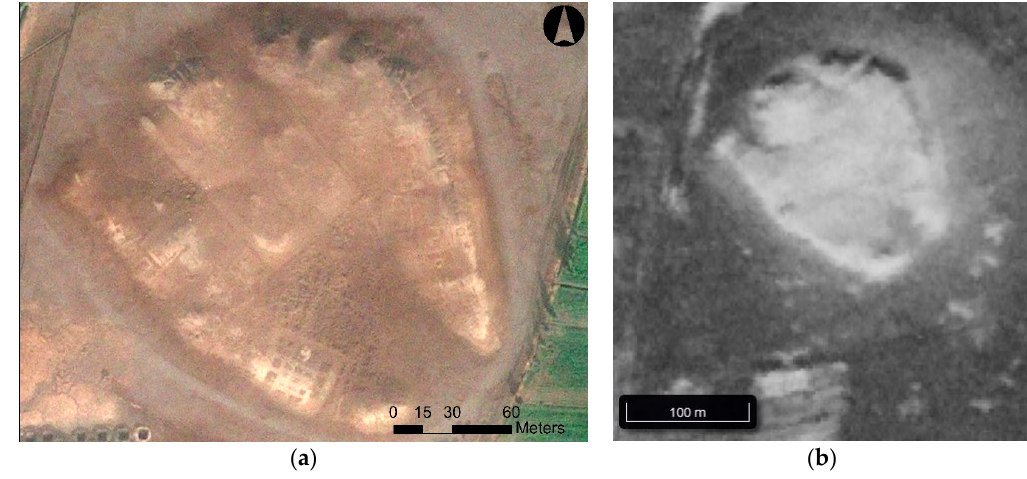
Figure 18. ( a ) The site of Tell Buweib. Image courtesy Google Earth; ( b ) 1968 CORONA image. Image courtesy of the Center for Advanced Spatial Technologies, University of Arkansas/U.S. Geological Survey.